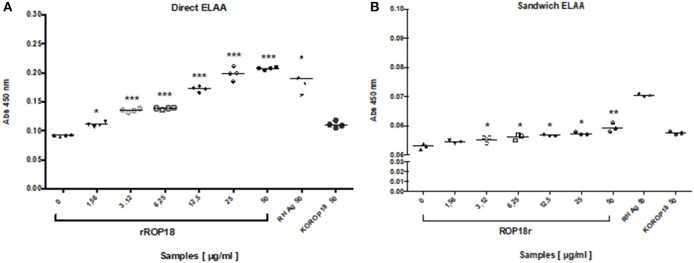
Evaluation of the detection limit of rROP18 protein in serum through direct (A) and sandwich (B) ELAA. Protein concentrations from 50 to 1.56 μg/mL diluted in serum from a seronegative individual for T. gondii were included. Total Ag of the RH strain (RH Ag at 50 μg / ml) was included as a positive control, and total antigen of the KOROP18 strain (KOROP18 at 50 μg / ml) was included as a negative control. The data are represented with the average of each sample evaluated in quadruplicate. Welch t test. *p < 0.05, **p < 0.01, ***p < 0.001 vs. the negative control KOROP18 (serum without antigen).